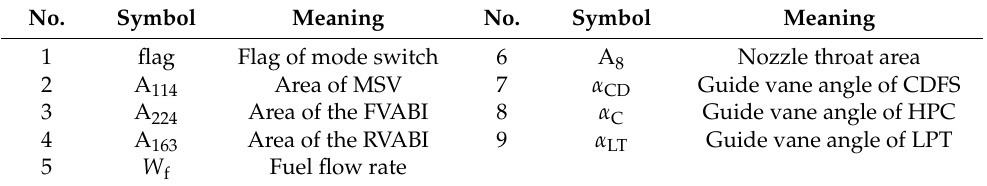
Table 1. Adjustable control variables of a variable cycle engine.